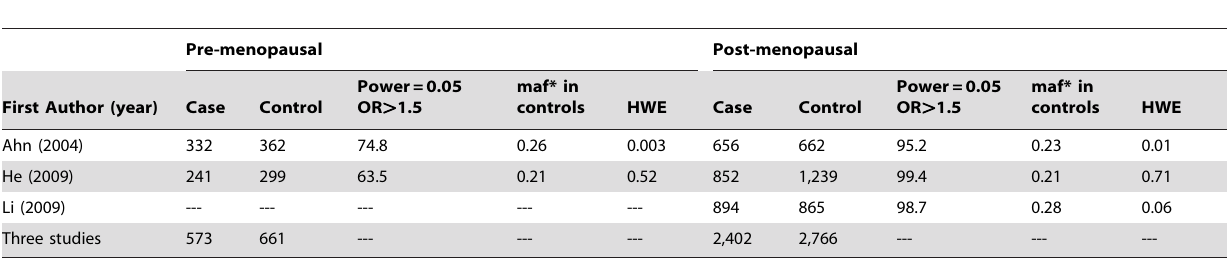
Table 1. Characteristics of the studies of MPO-G463A polymorphism and its association with breast cancer according to menopausal status.